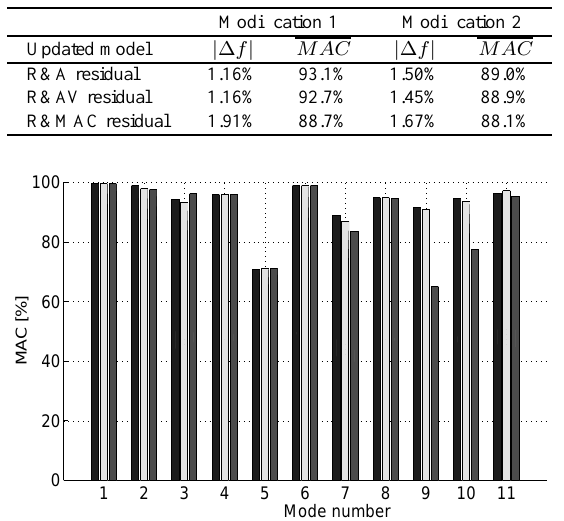
Fig. 11. Frequency deviation after modification 1 of the updated model: R&A dark gray, R&AV light gray, R&MAC medium gray. Table 7 Results after modification 1 and 2